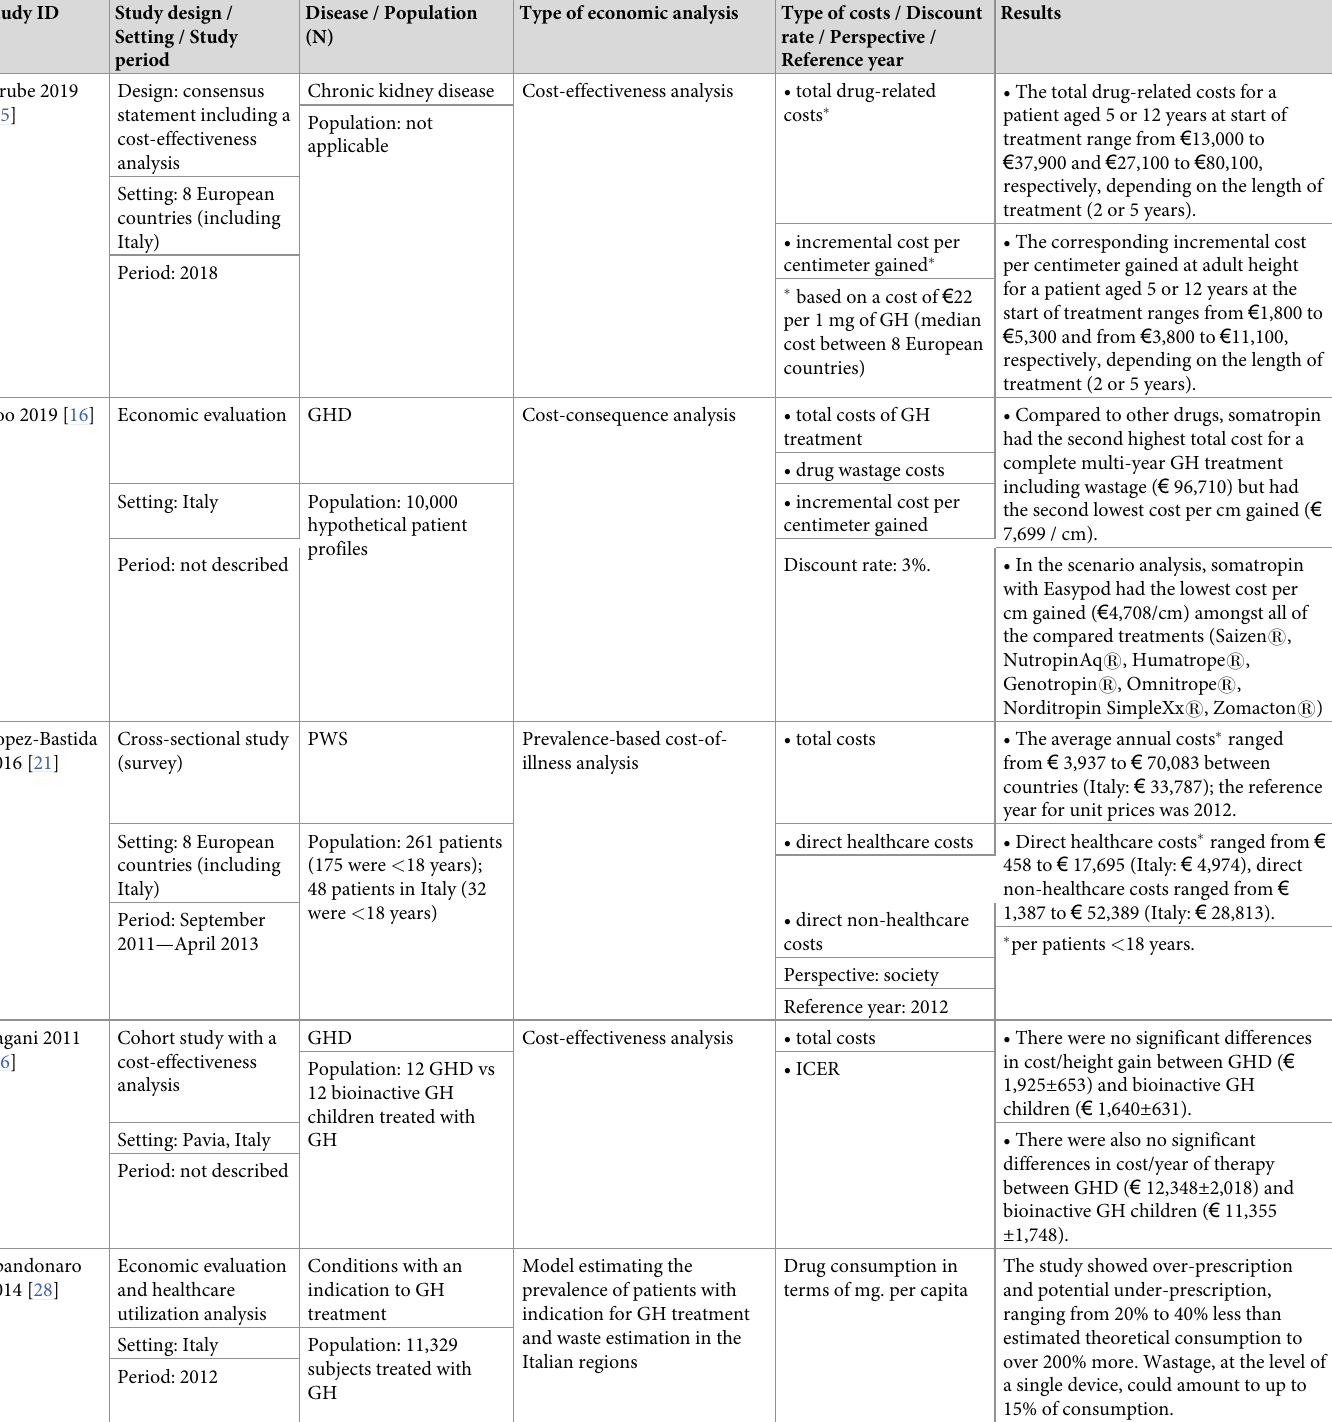
Table 4. Characteristics of included studies for economic